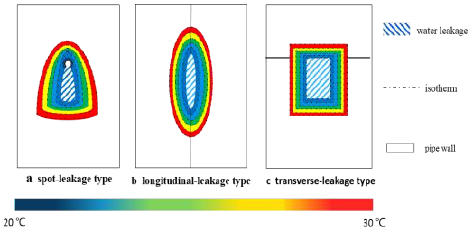
Figure 3. The temperature distribution characteristic of different